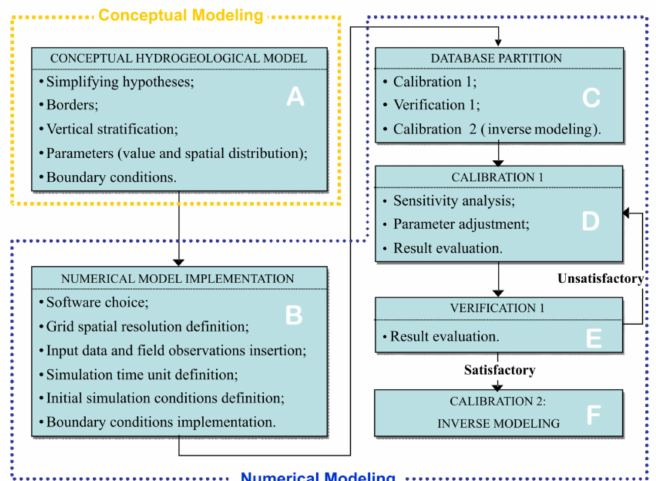
Figure 2. Steps of the numerical modelling method. ( A )Items of the conceptual hydrogeological model; ( B ) steps of the numerical model implementation; ( C ) database partition between model- ing steps; ( D )steps of the calibration process; ( E ) calibration process evaluation; and ( F ) recharge estimation by inverse modelling